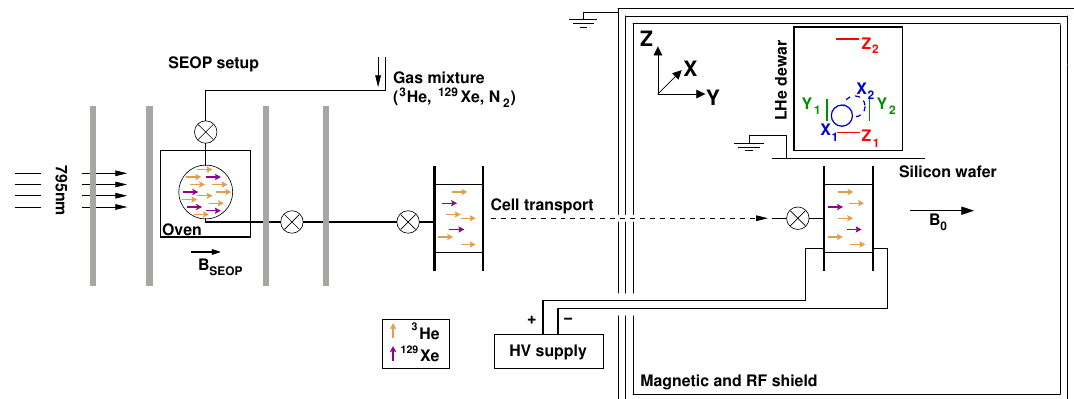
Figure 4. Scheme of the HeXeEDM experimental setup: In a spin-exchange optical pumping (SEOP) setup located outside a magnetically shielded room (MSR), the noble gas nuclei of 3 He and 129 Xe are simultaneously spin polarized. After filling the polarized gas mixture into an evacuated EDM cell, the cell is transported into the MSR and placed underneath a liquid helium dewar housing SQUID sensors. After an initial spin flip, nuclear spin precession of both species is detected in applied magnetic ( ∼ 1–2 µ T) and electric ( ∼ 3 kV/cm)